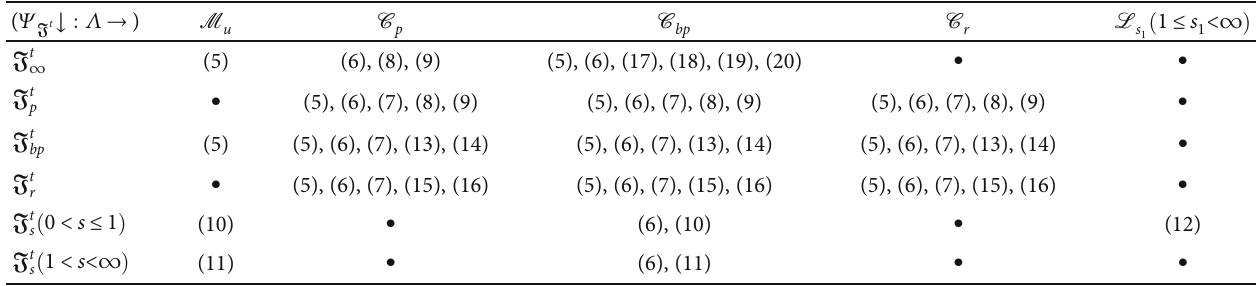
g , C , C , C , L u bp p r s